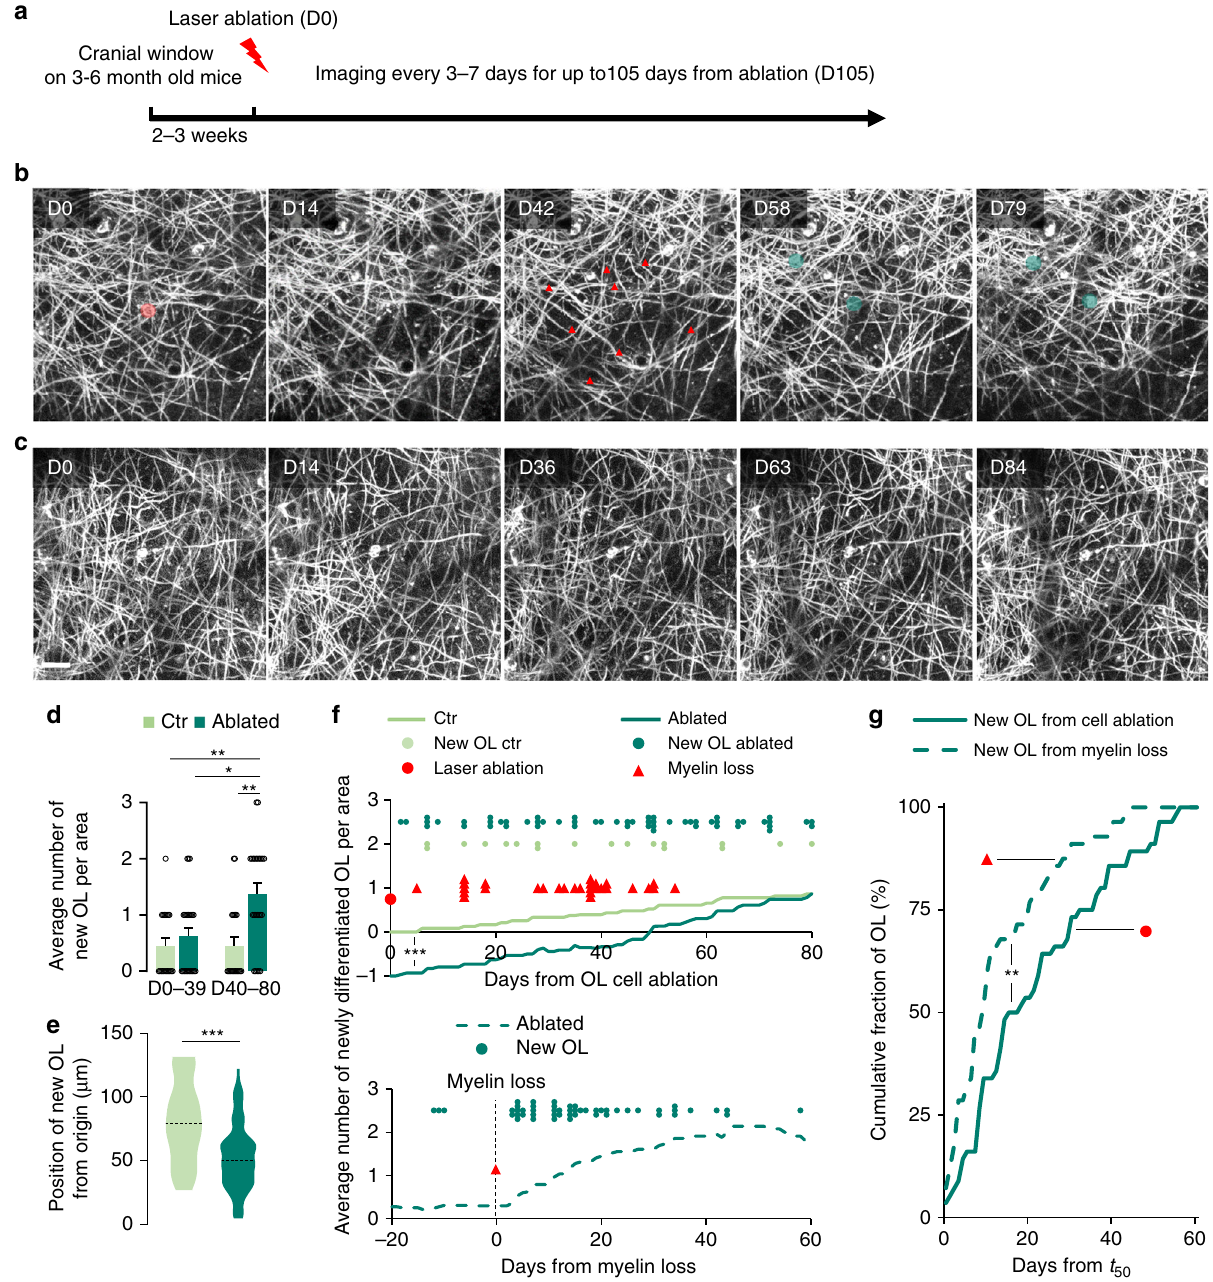
Fig. 1 Demyelination due to single OL ablations triggers OPC differentiation in the cortex. a Schematic representation of the experiment timeline. b Longitudinal in vivo imaging of demyelination after single OL laser ablation (ablated cell highlighted in red at D0 and lost myelin segments marked by red arrowheads at D42) followed by new OL maturation and remyelination in Plp :GFP mice (new cells highlighted in green from D58). c Longitudinal in vivo imaging of non-ablated control area. Display b , c Maximum intensity projections of 30 µ m. d Average number of newly matured OLs per area ( x / y / z